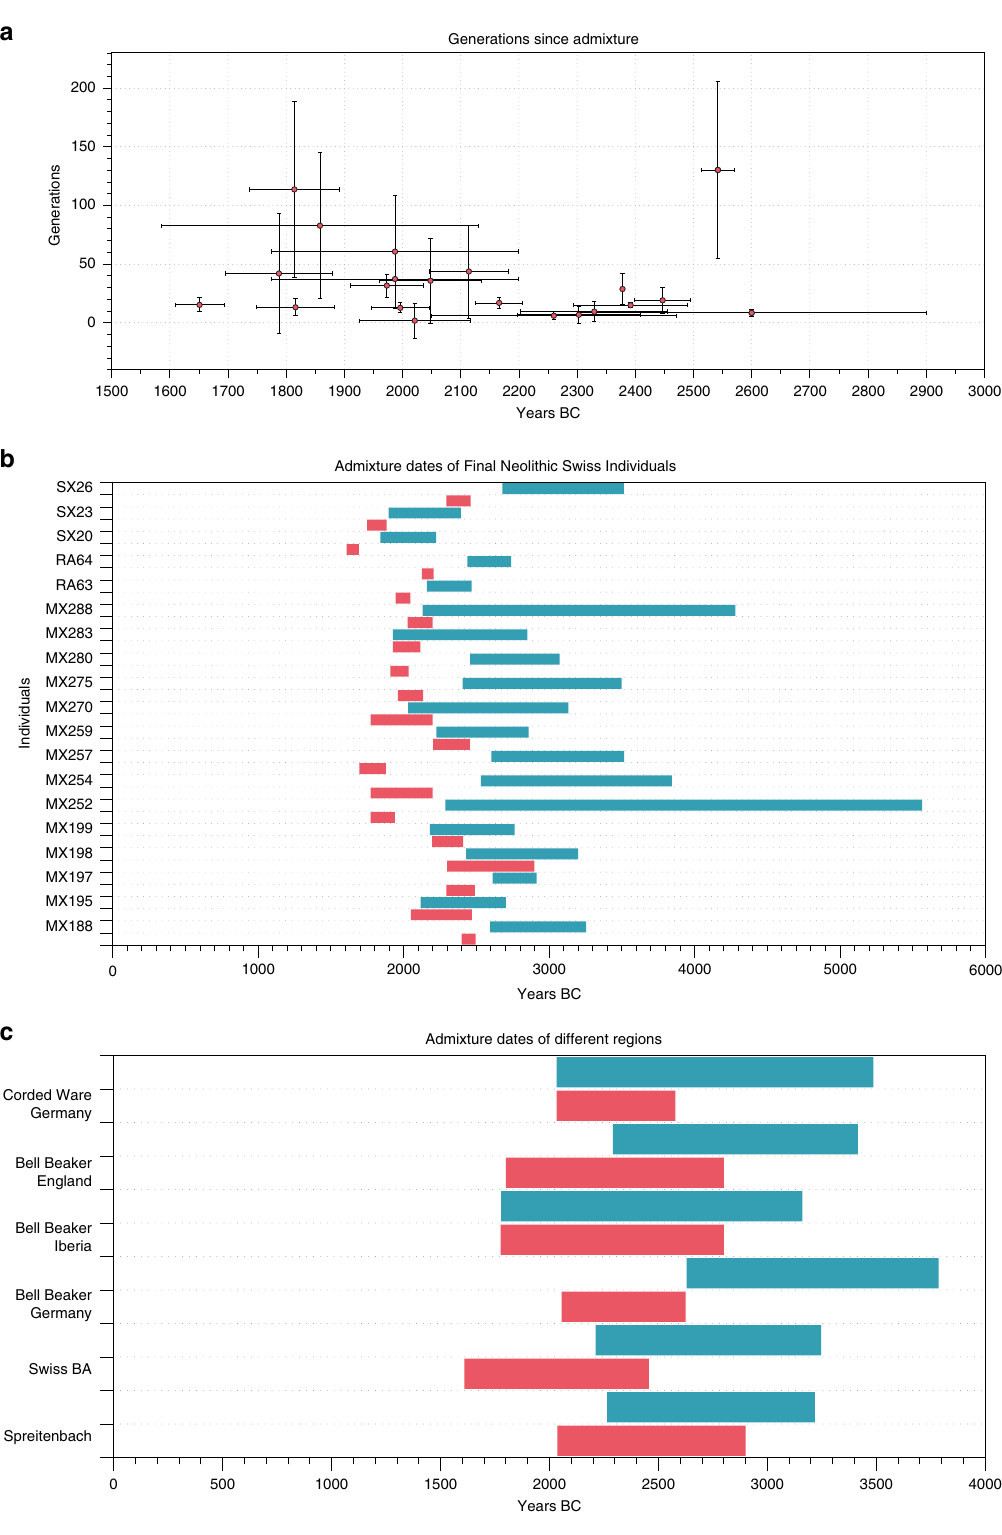
Fig. 3 Estimated admixture times between the Yamnaya-like steppe component and the Middle Neolithic population using DATES software. a Admixture dates of single individuals are plotted against their calC14 dates (horizontal error bars indicate uncertainty in C14 dating and vertical error bars show 95% con fi dence interval of generation times) and b displayed as time range (C14 dates in red and estimated admixture dates in turquoise). c Admixture dates of grouped individuals according to their regions of origin were calculated (colors as